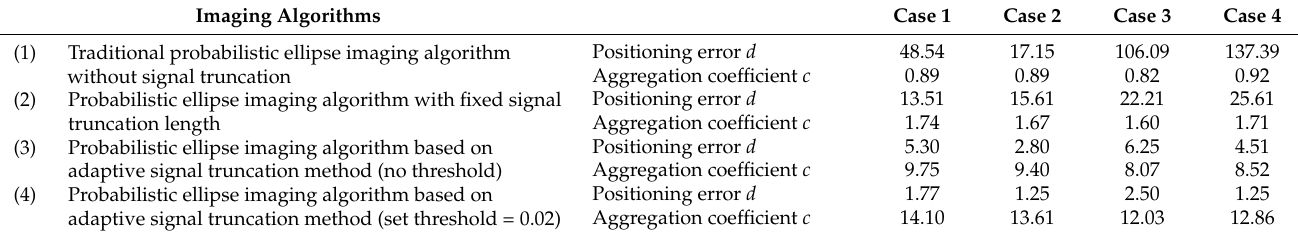
Table 3. Deviations and aggregation coefficients of localization results of different probabilistic el ‐ lipse imaging algorithms.